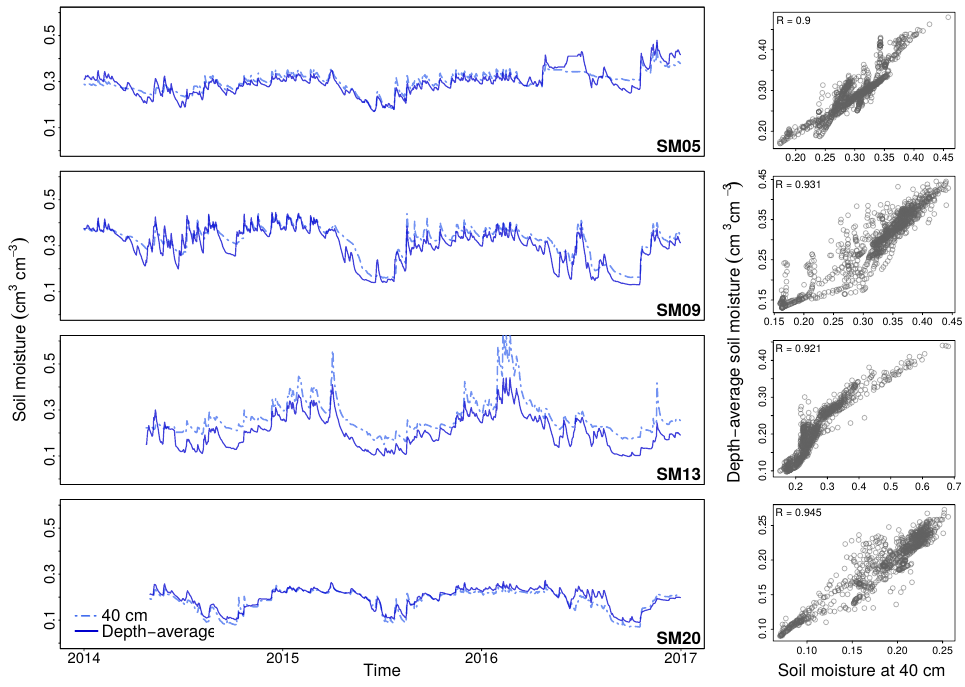
Figure 9. Subsurface soil moisture dynamics for vertically discrete (40cm) and depth-average value. Left panels: time series of soil moisture at 40cm and depth-averaged values. The dynamics observed for depth-average values are highly similar to those at 40cm. Right panels: scatter plot showing that these two sets of values are highly